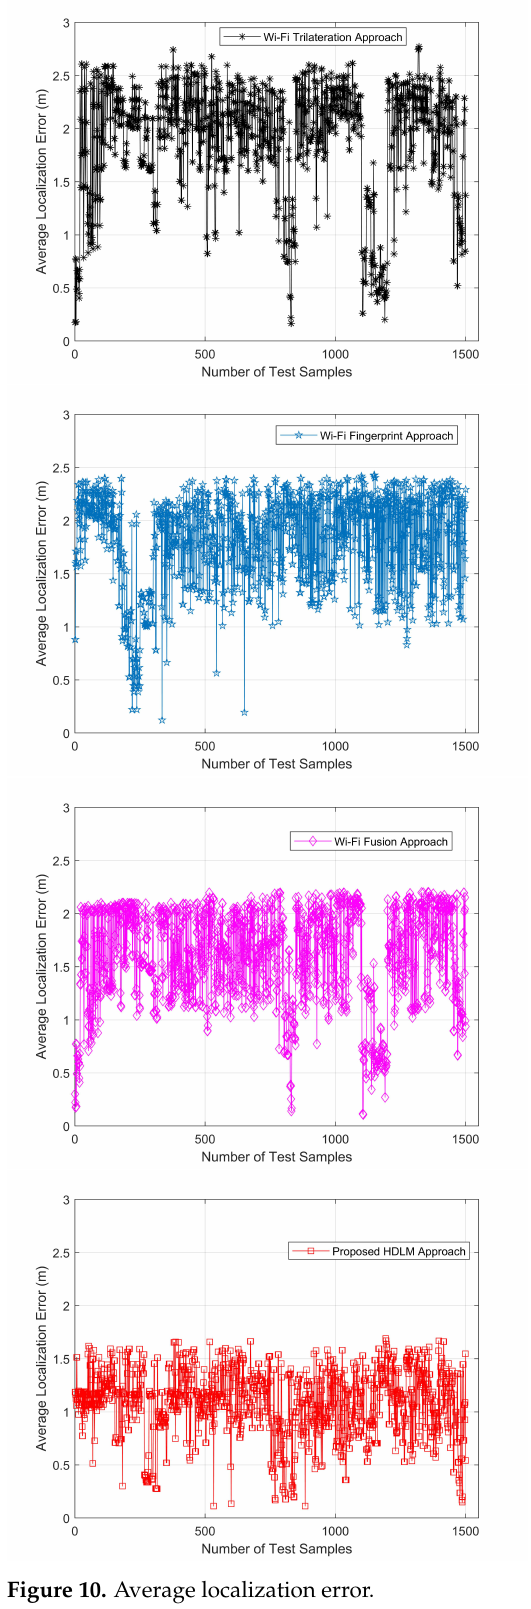
Figure 10. Average localization